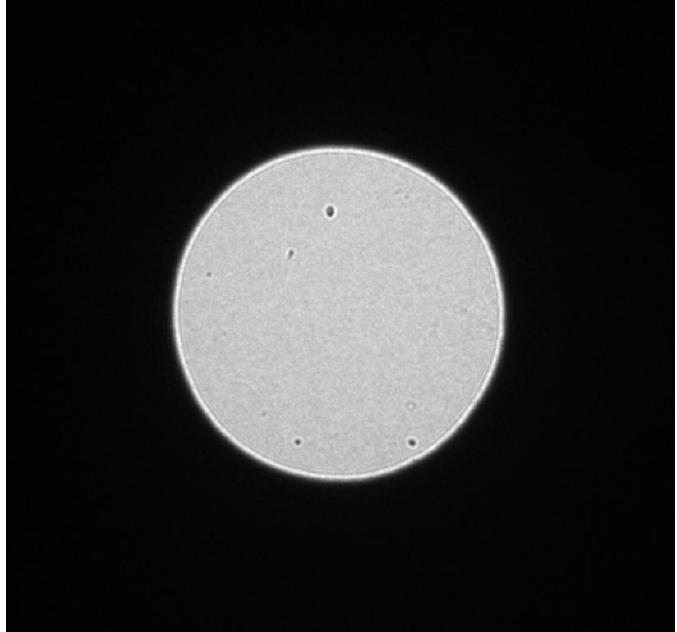
Figure 7. In line-hologram on cocrystals of caffeine and glutaric acid as acquired in diffraction mode and exposed to 1.2 e − Å −2 .